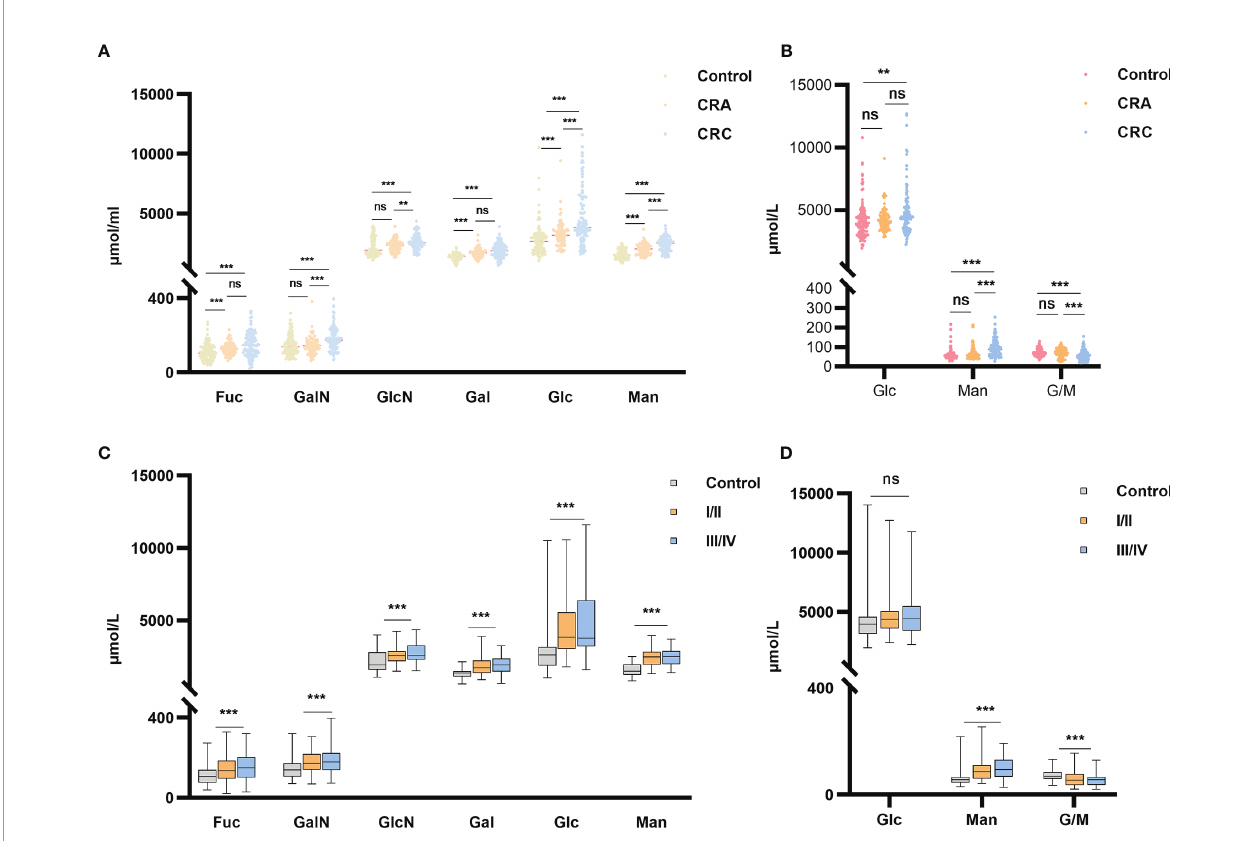
FIGURE 3 | Free and hydrolyzed glycan monosaccharide concentrations in sera of healthy individuals, CRC and CRA patients. (A) Six hydrolyzed monosaccharides in sera of the healthy individuals, CRA and CRC groups. (B) Two free monosaccharides and their ratio in sera of the healthy individuals, CRA and CRC groups. (C) Six hydrolyzed and (D) Two free monosaccharide concentrations in sera of healthy individuals and CRC at stages I/II vs. stages III/ IV. *** p ≤ 0. 001, ** p ≤ 0.01, ns, not signi fi